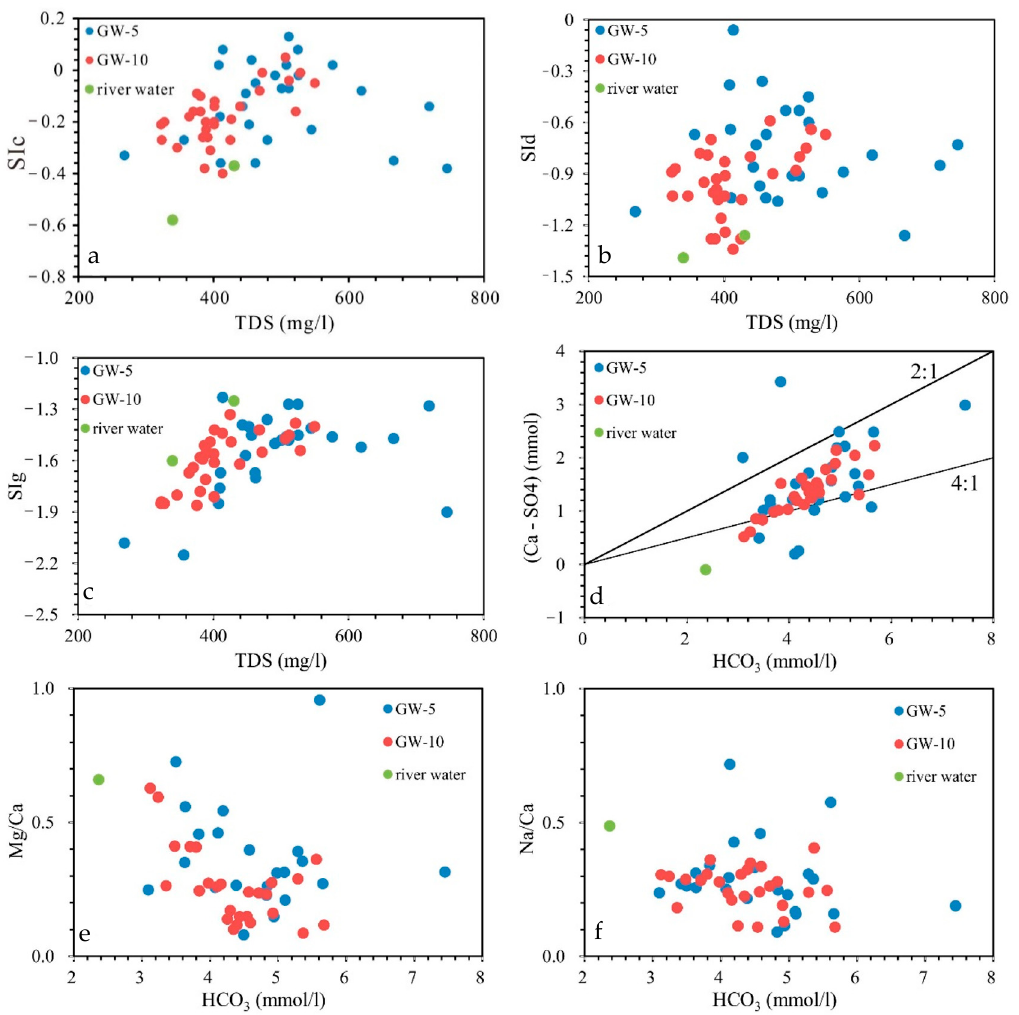
Figure 3. Relationship between TDS(Total dissolved solids ) and saturation index of calcite (SIc) ( a ), TDS and saturation index of dolomite (SId) ( b ), TDS and saturation index of gypsum (SIg) ( c ), HCO 3 and (Ca-SO 4 ) ( d ), HCO 3 and Mg/Ca ( e ), and HCO 3 and Na/Ca ( f ) in groundwater and river water. (In this figure the following figures, the GW-5 represents the groundwater collected in May and GW-10 represents the groundwater collected in October